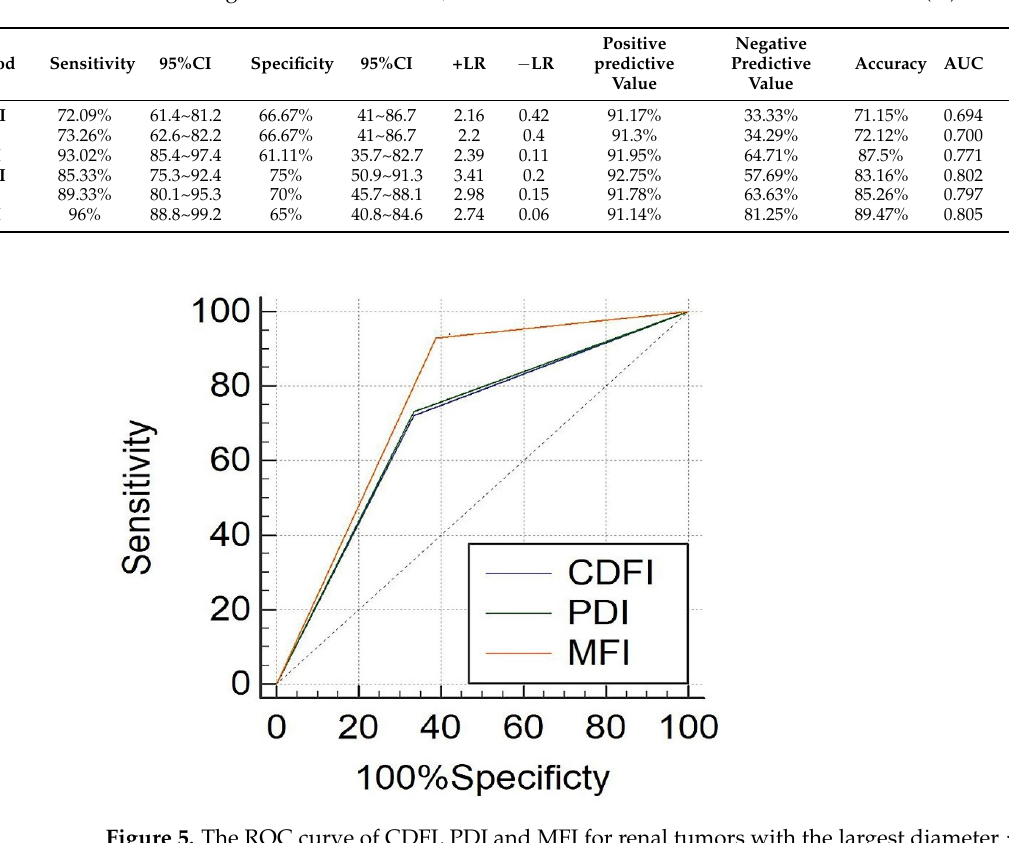
Table 5. Diagnostic result of CDFI, PDI and MFI for renal tumors of different sizes (%).